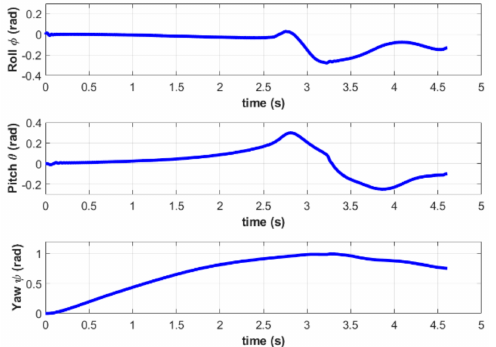
Figure 15. Attitude of the quadrotor in simulation B.